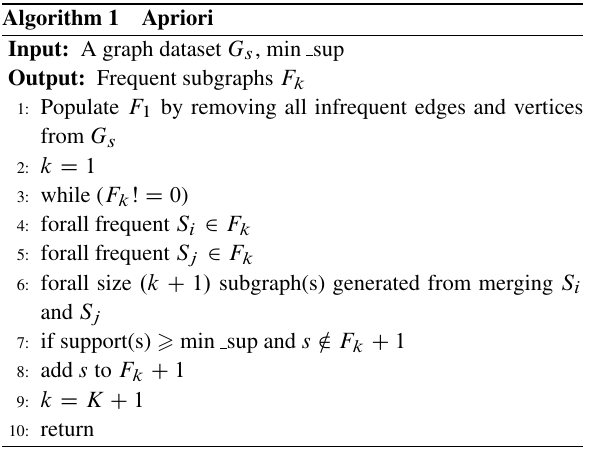
Fig. 4 Apriori-based